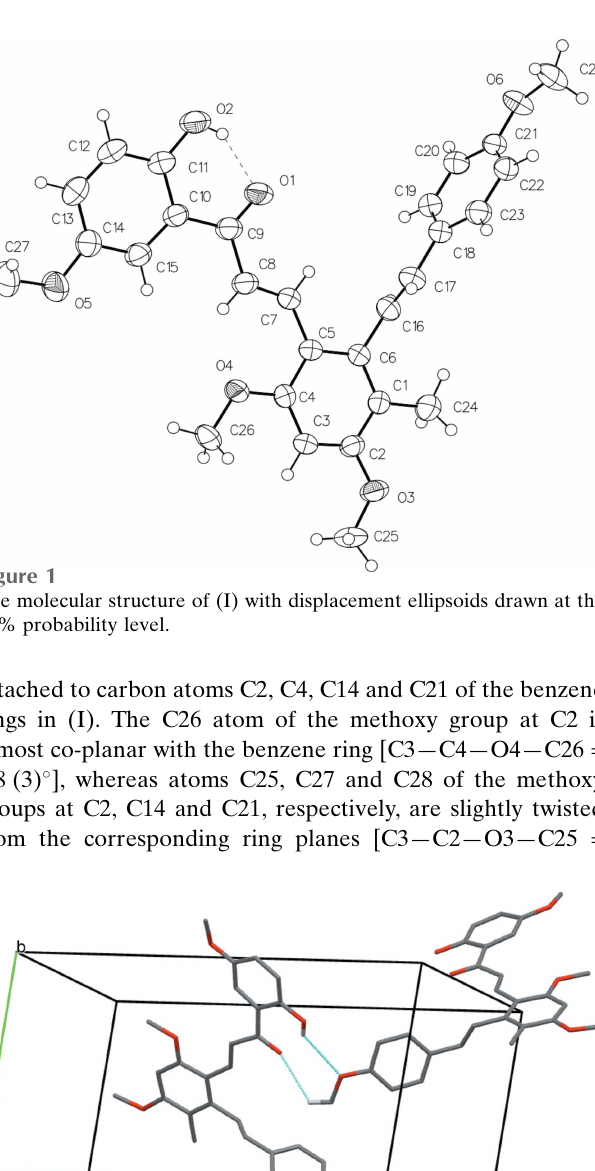
Figure 2 Aview of a dimer linked by pairwise C—H (cid:2)(cid:2)(cid:2) O hydrogen bonds (dashed lines) in the crystal structure of (I). For clarity only those H atoms involved in hydrogen bonding are shown.